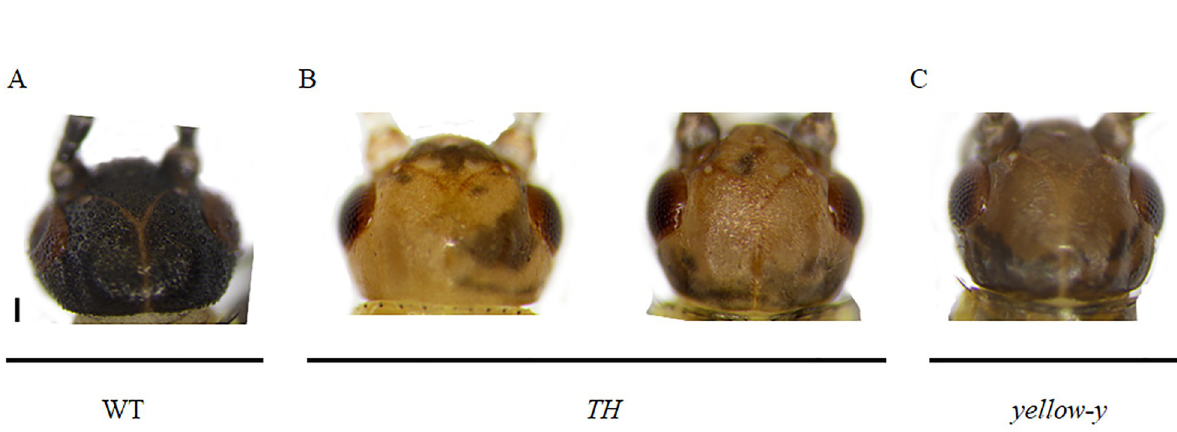
PLOS ONE | https://doi.org/10.1371/journal.pone.0284124 April 10, 2023 12 /